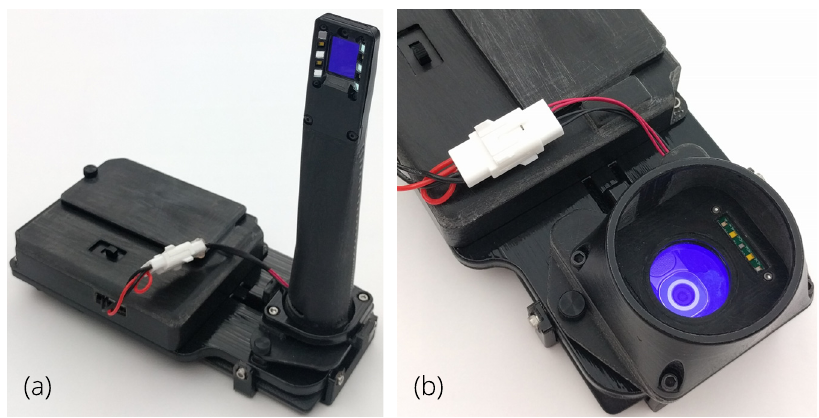
Fig 1. Smartphone-based oral cancer screening device using both WLI and AFI. Interchangeable modules installed on a common platform allow for both (a) intraoral imaging and (b) whole cavity imaging.